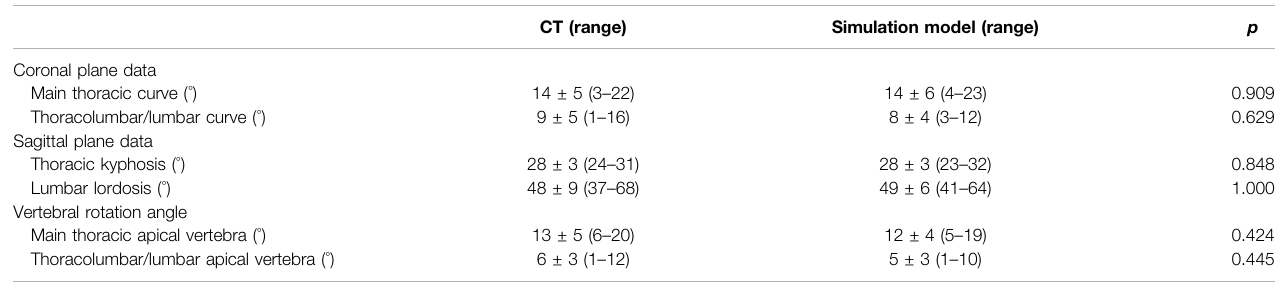
TABLE 5 | Postoperative CT and simulation model parameters in patients with Lenke type 1